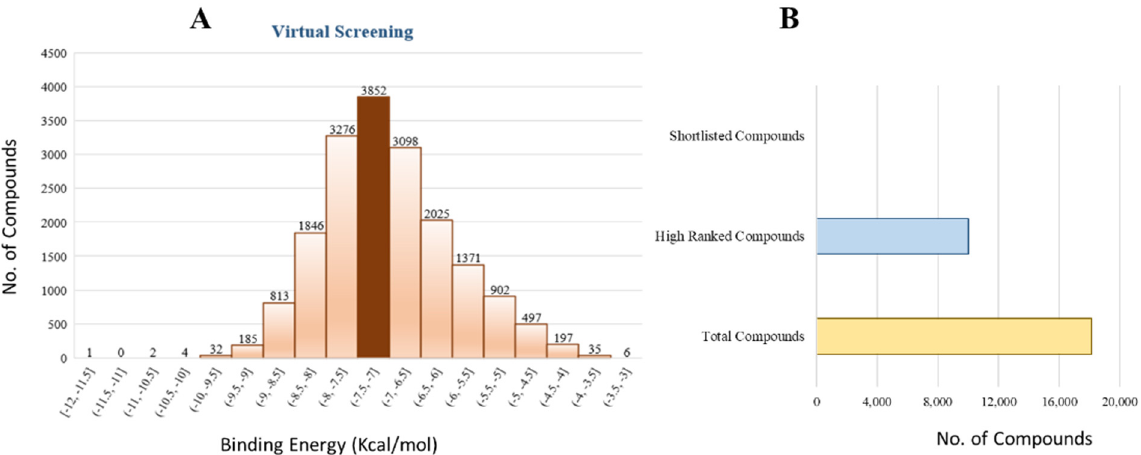
Figure 7. Virtual Screening: ( A ) Virtual screening studies for ICL using Zinc library of 18,000 compounds showing the binding energies ranging from the − 3 to − 12 kcal/mol. The resulted showed that about 3852 compounds docked at same position with the binding energies of − 7 to − 7.5 kcal/mol (brown color). ( B ) showing the overall summary of virtual screening from total of 18,00 compounds to 10, 000 high ranked compounds and finally resulted in the identification of six potential inhibitors i.e., ZINC95543764, ZINC02688148, ZINC20115475, ZINC04232055, ZINC04231816, and ZINC04259566.